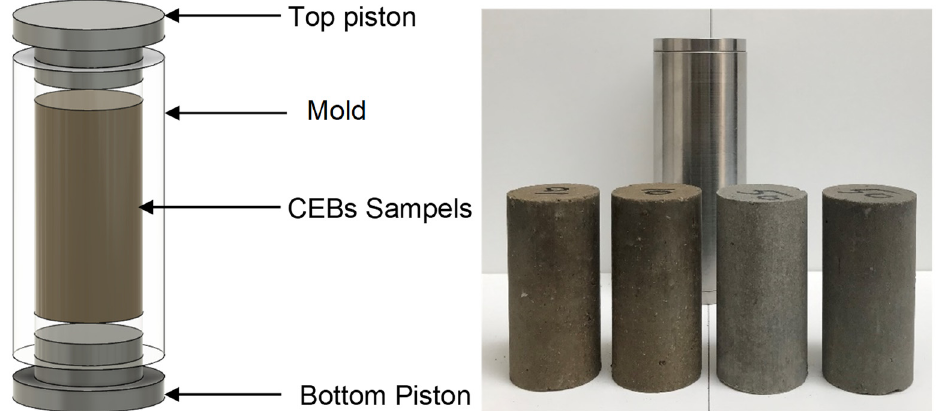
Figure 4. Preparation of CEBs samples. Table 4. Composition of CEBs